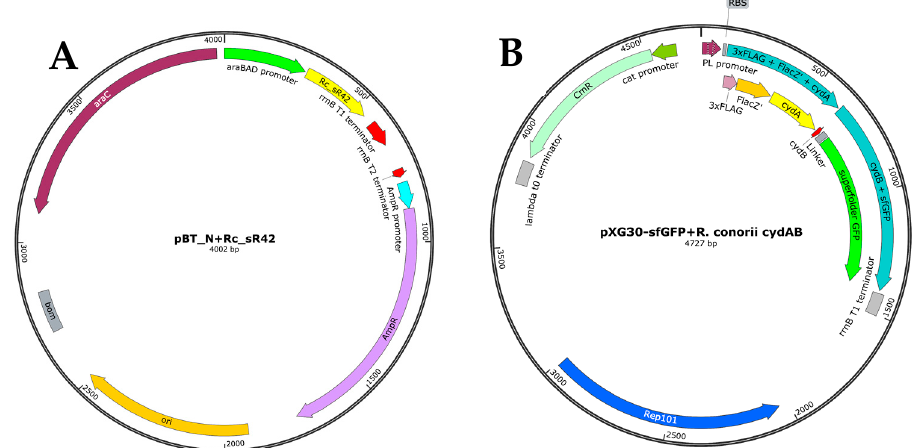
Figure 3. Plasmids constructed for the expression of R. conorii sRNA Rc _sR42 and partial cydAB bicistronic mRNA. ( A ) Plasmid map showing cloning of the sRNA downstream of an inducible arabinose promoter and upstream of a strong rrnB T1 terminator. ( B ) pXG30-sfGFP bicistronic plasmid construct expressing last 87 amino acids of cydA tagged to ‘FLAG-LacZ’ at the 3 ′ end, and first 7 amino acids of cydB tagged to GFP at the 5 ′ end of the coding sequence.